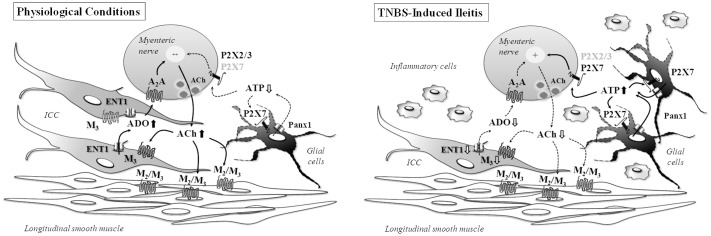
Inflammation-induced cholinergic hypoactivity is deeply dependent on the purinergic shift from a preferential adenosinergic tone under physiological conditions to a more prevalent ATP-mediated control of ACh release in TNBS-induced ileitis. The post-inflammatory loss of ICCs correlates with adenosine deficiency in the ileum of TNBS-treated rats breaking down facilitation of cholinergic neurotransmission operated by muscarinic M3 receptors-induced adenosine overflow from ICCs via ENT-1 and activation of pre-junctional facilitatory A2A receptors. Adenosine depletion contrasts with the excess of ATP released from proliferating glial cells after the inflammatory insult and may also be explained by deficient formation from release adenine nucleotides by NTPDase cascade redistribution and excess of catabolism by adenosine deaminase (ADA) overproduction in inflammatory tissues (see Vieira et al., 2014). Extracellular ATP accumulation contributes to maintain the cholinergic tone at a minimum through the activation of high affinity / fast desensitizing pre-junctional P2X2 and/or P2X2/3 receptors. Inflammatory-induced neuronal to non-neuronal shift of ACh release is also intimately tight to a mechanism involving low affinity / slow desensitizing ionotropic P2X7 receptors and surplus ATP release via pannexin-1 hemichannels from proliferating glial cells. This scenario admits that post-inflammatory ileitis recapitulates an ancestral mechanism by which ATP released by glial cells directly (via ionotropic P2X receptors) stimulates ACh release from cholinergic nerve terminals even when these cells are disturbed and unable to generate normal action potentials. ACh: acetylcholine; ADO: adenosine; ENT1: equilibrative nucleoside transporter 1; ICC: interstitial cells of Cajal; Panx1: pannexin-1 hemichannels. Solid arrows indicate preferential mechanisms, while dotted arrows are assigned to deficient paths.